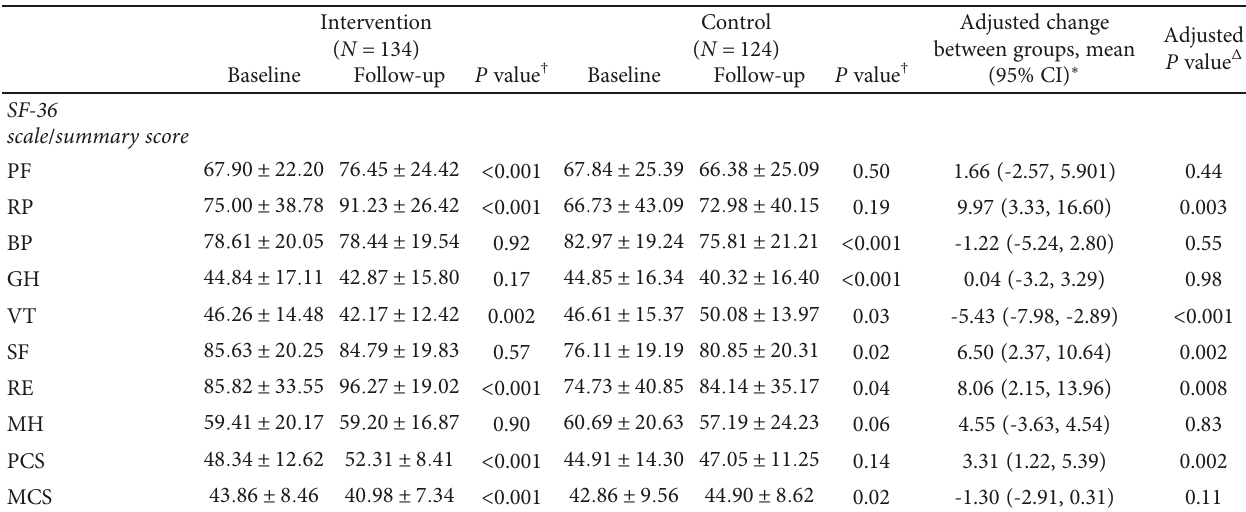
Table 4: Comparison of the SF-36 scores between the intervention and control groups from baseline to postintervention in a 9-month group randomized experimental study in China,